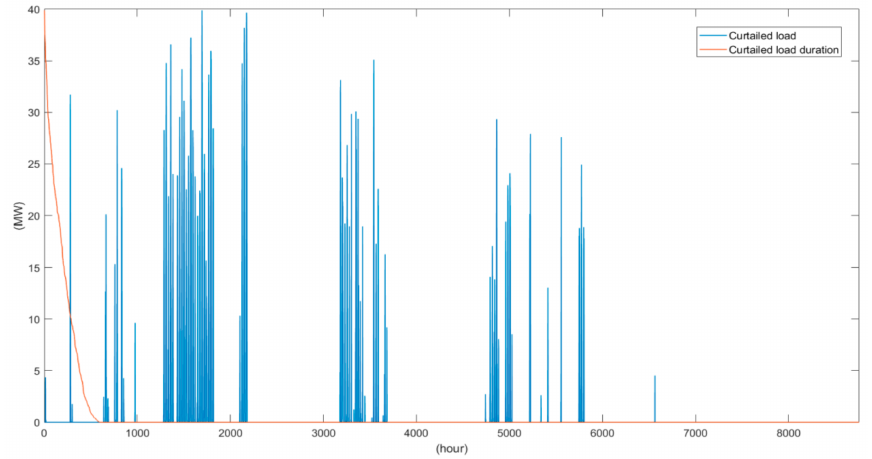
Figure 2. Curtailed energy in the energy system of